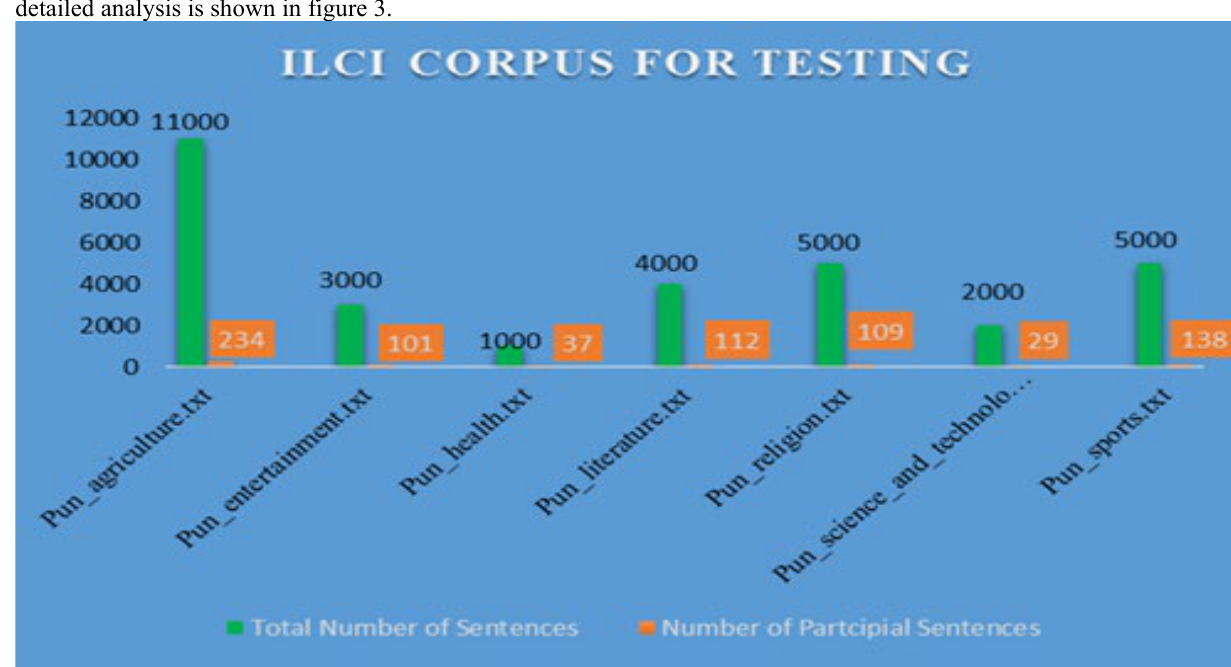
Figure 3. Details of ILCI corpus used for